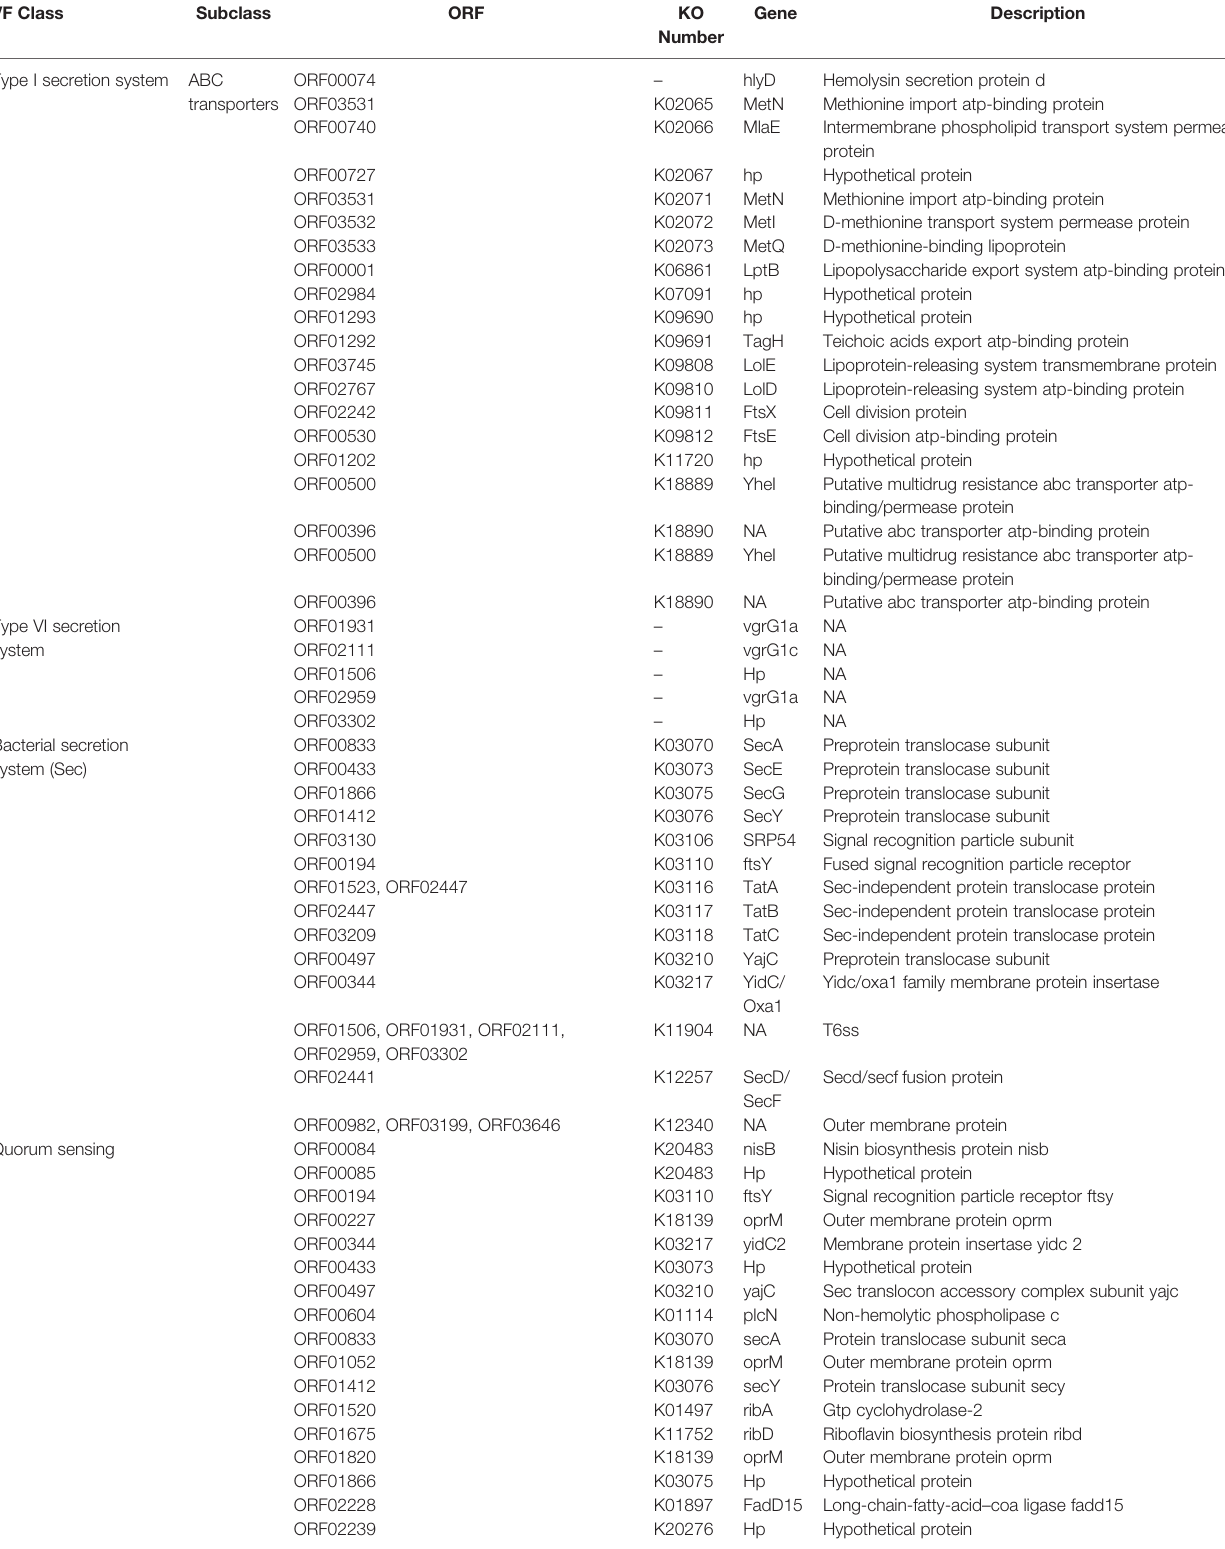
TABLE 2 | List of predicted virulence factors and their respective VF